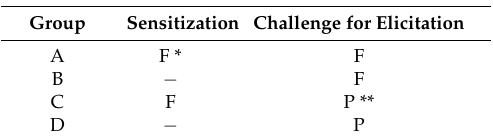
Table 2. Experimental groups of suppression of contact dermatitis to Pd-induced allergy by oral administration of fexofenadine or prednisolone.